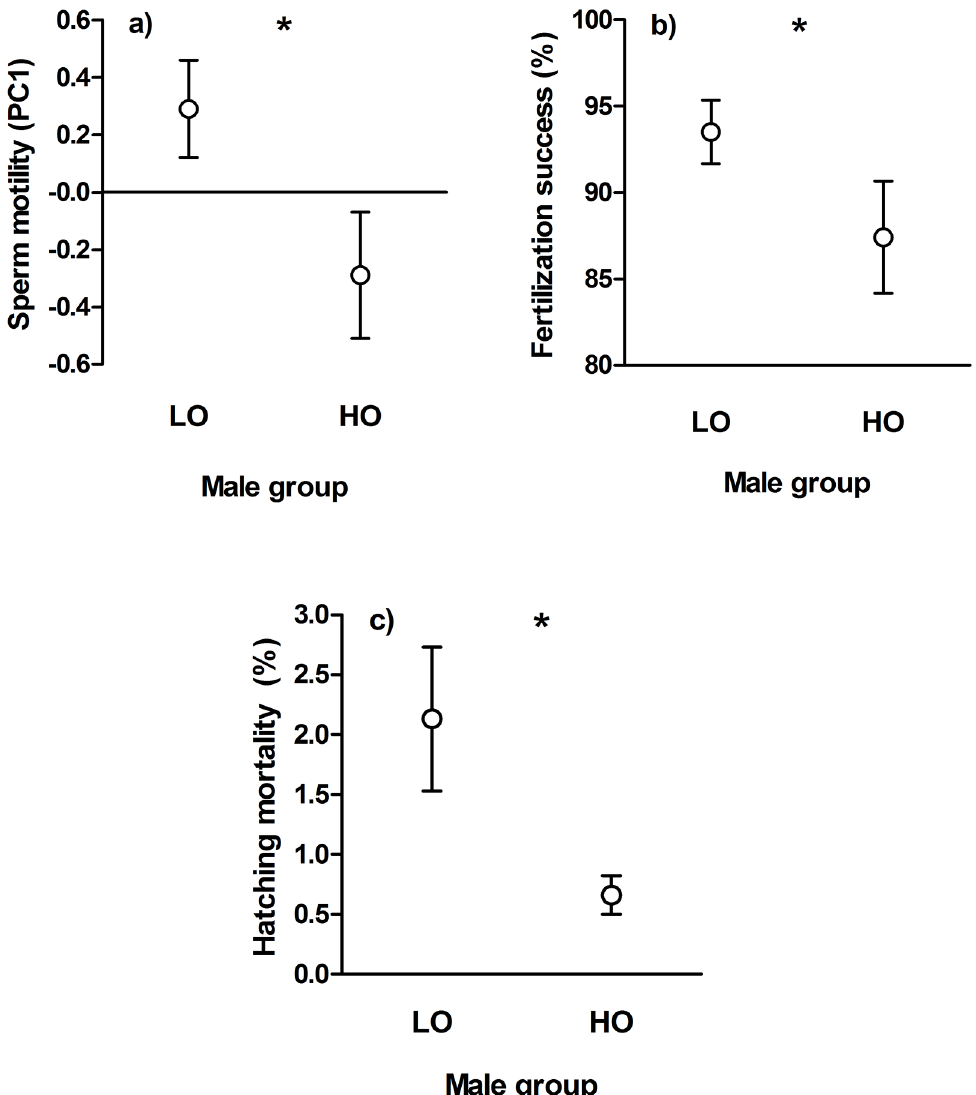
Fig 1. Sperm motility (a), fertilization success (b) and hatching mortality (c) differences ( ± S.E.) between less-ornamented (LO) and highly- ornamented (HO) males. Asterisks indicate statistically significant differences between male groups ( * : P <